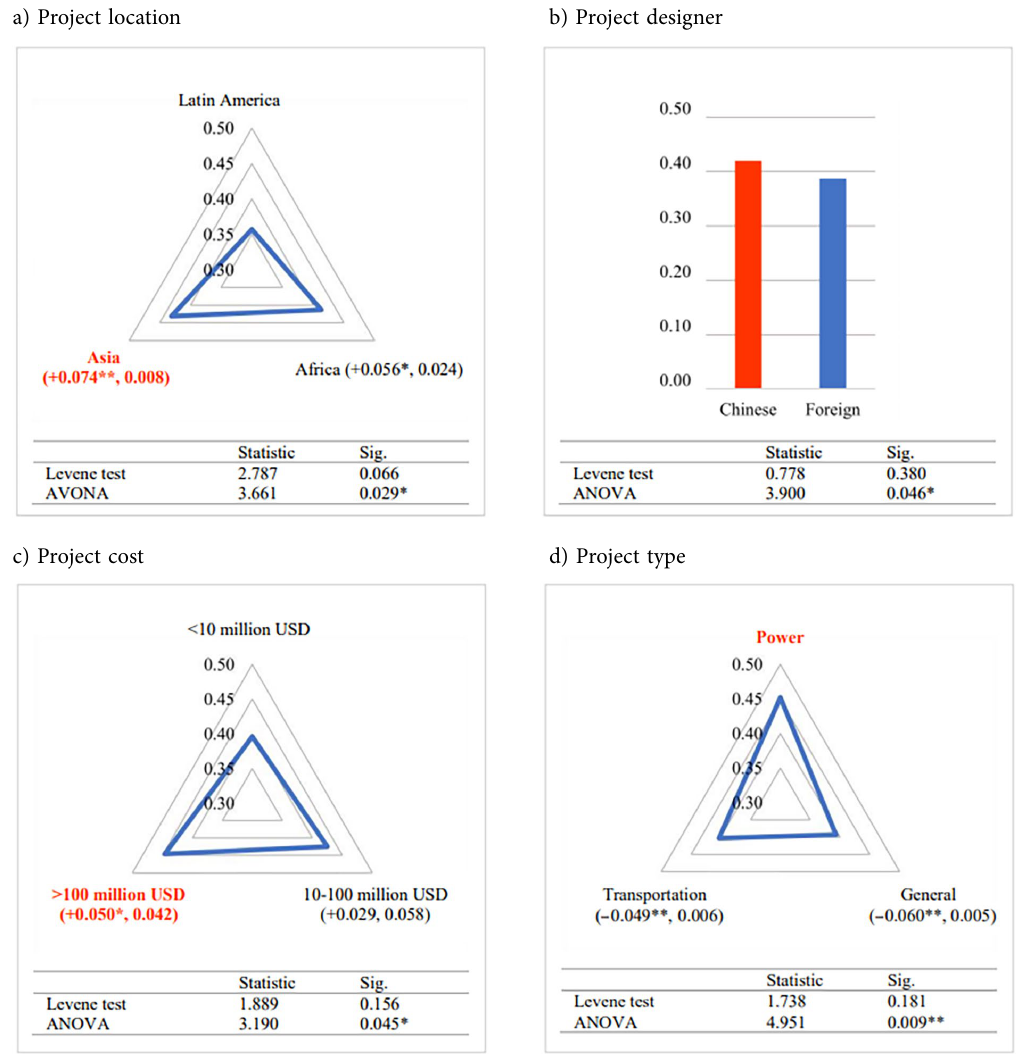
Figure 4. One-way variance analysis of project time performance using data collected from